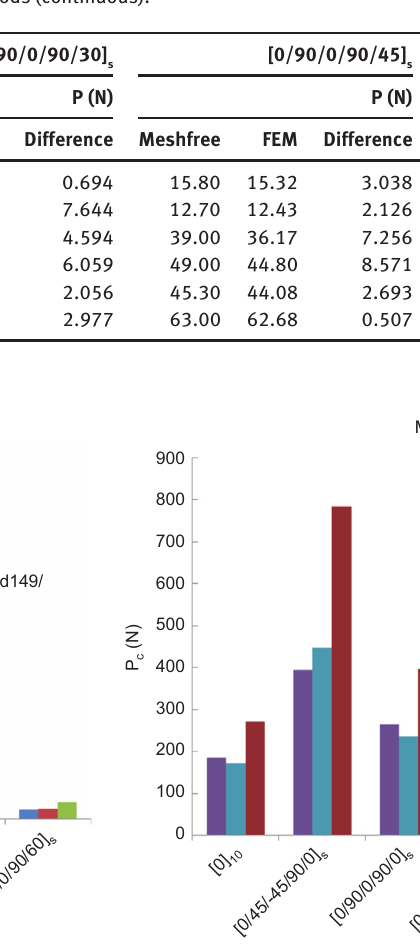
Figure 12 Critical loads for various orientation angles.